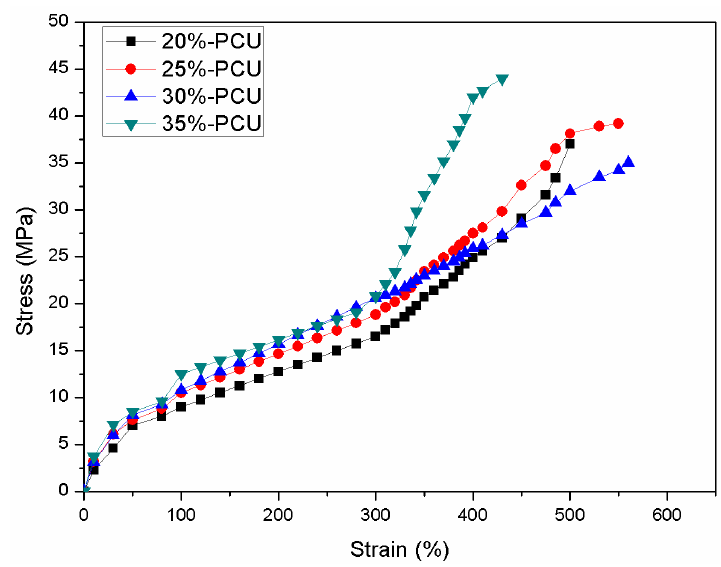
Figure 6. Tensile stress-strain curves of different contents of hard segments of the polyurethanes. Table 2. Comparison between the polyurethane films and other commercial polyurethane products. Samples